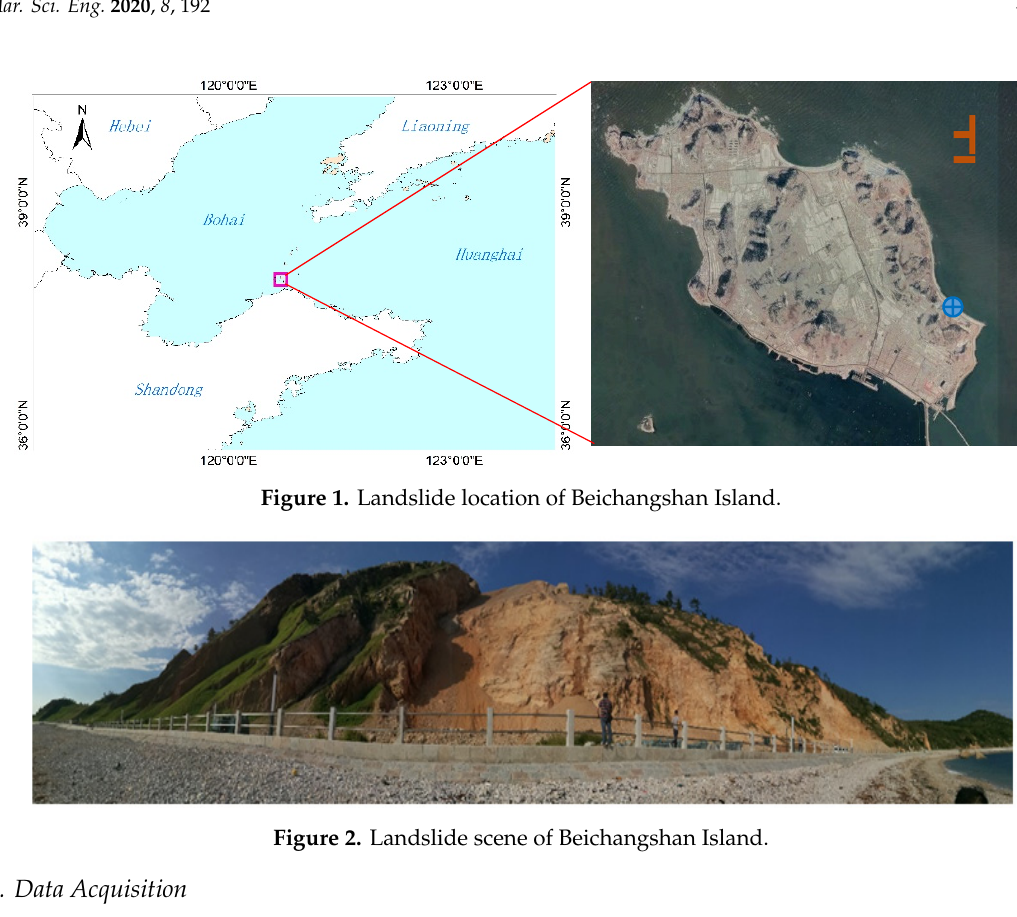
Figure 2. Landslide scene of Beichangshan Island.